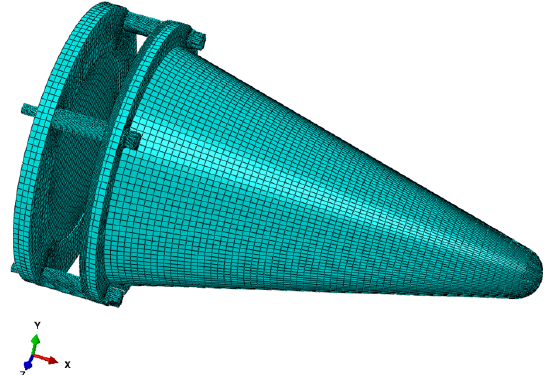
Figure 6. Meshes of the finite element model of the system.